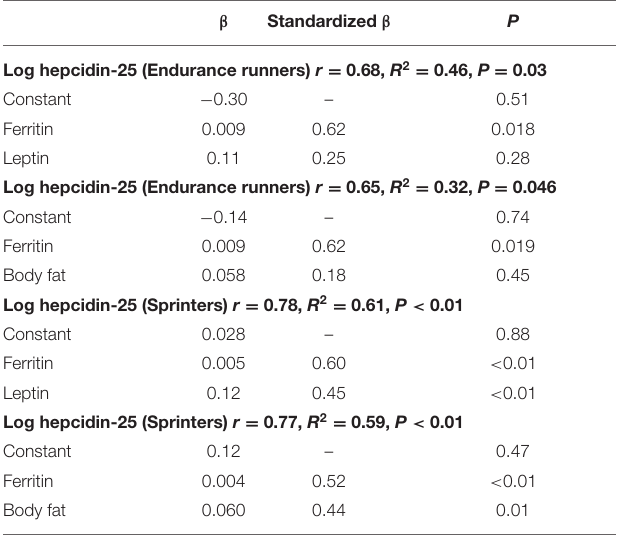
TABLE 3 | Hepcidin-25 level is correlated with leptin and body fat in sprinters but not in endurance runners. β Standardized